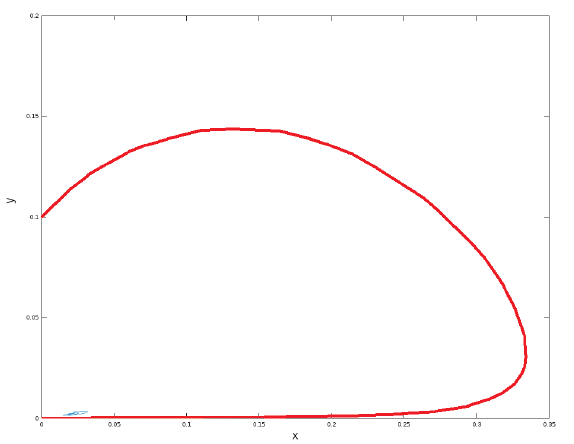
Figure 3. For the same parameters as in Figure 2 two solution curves of (14) with (cid:101) = (cid:101) ( x , y ) given by (15) with (cid:101) 0 : = 21/22, the red one tends to the disease-free equilibrium and approximately separates the two basins of attraction, while the blue one first is nearly identical with the red one, but finally tends to the endemic equilibrium on the left